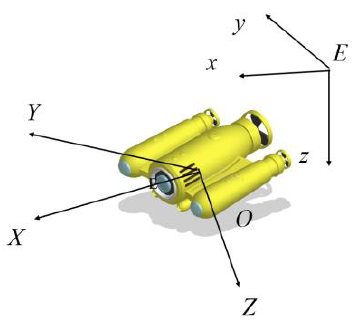
Figure 1. Coordinate diagram.